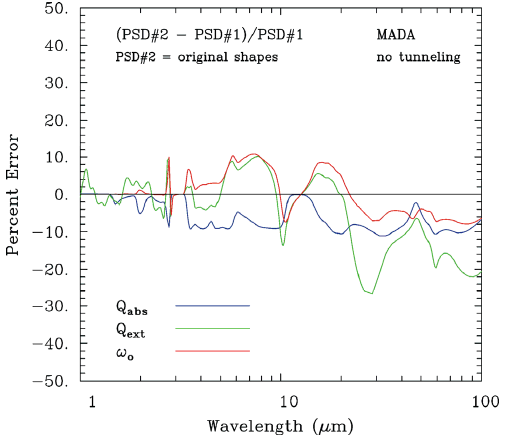
Figure 15. Same as in Fig. 8 (D e = 39 μ m) but without the process of photon tunneling. MADA optics was used here to remove the tunneling process.